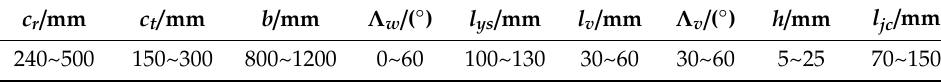
Table 2. Parameter range of the tailsitter